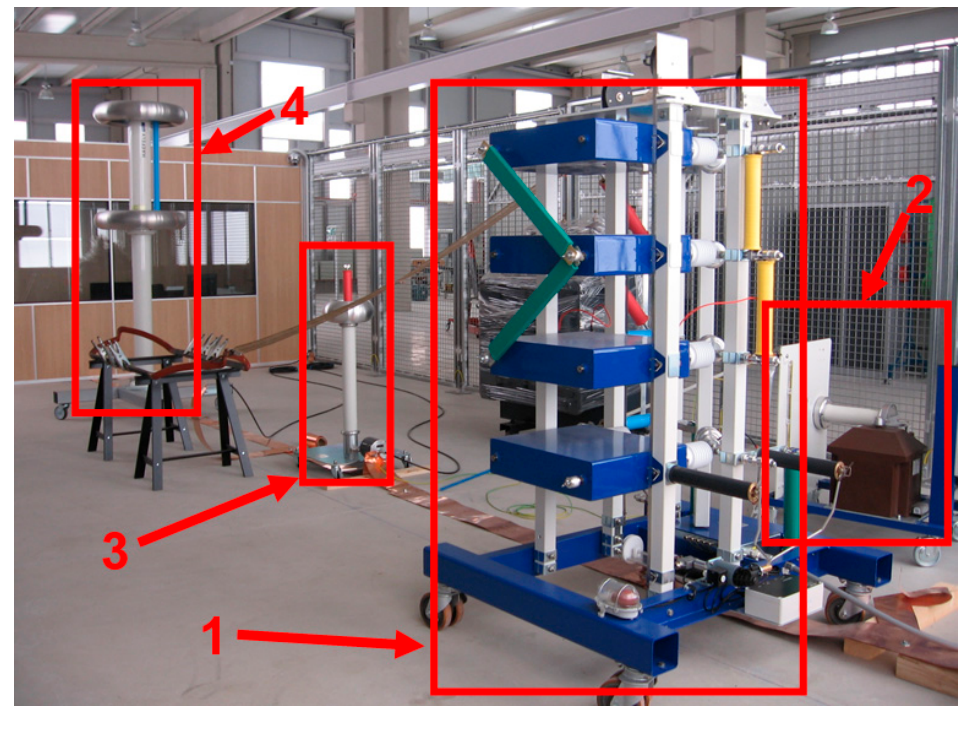
Figure 1. Test rig (1) pulse generator, (2) charge unit, (3) capacitive divider, (4) compensation circuit.